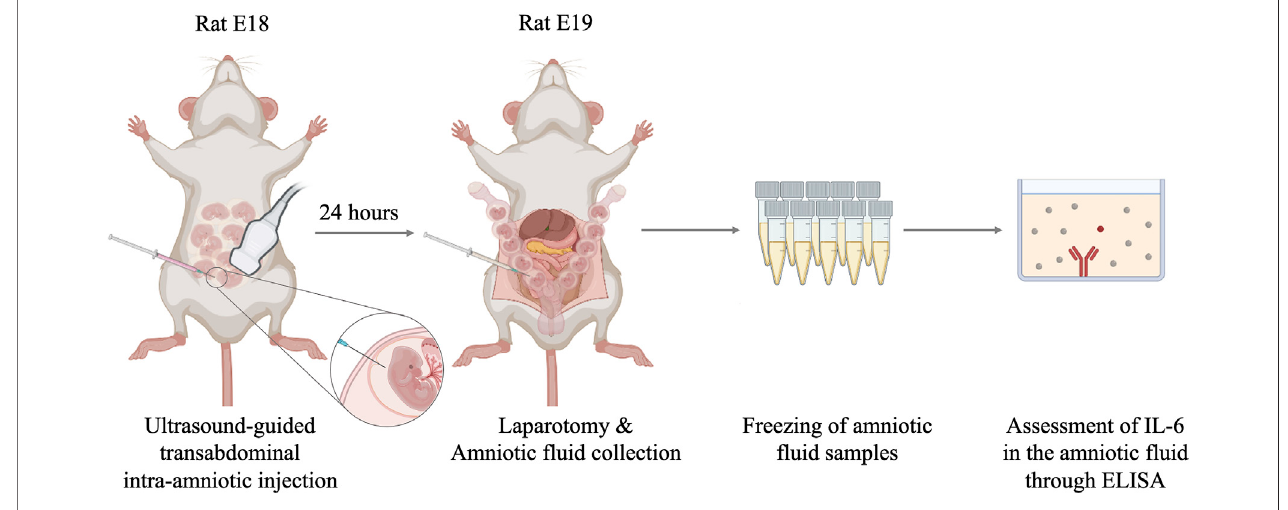
FIGURE 1 | Graphic illustration of the experimental design. IL: interleukin.